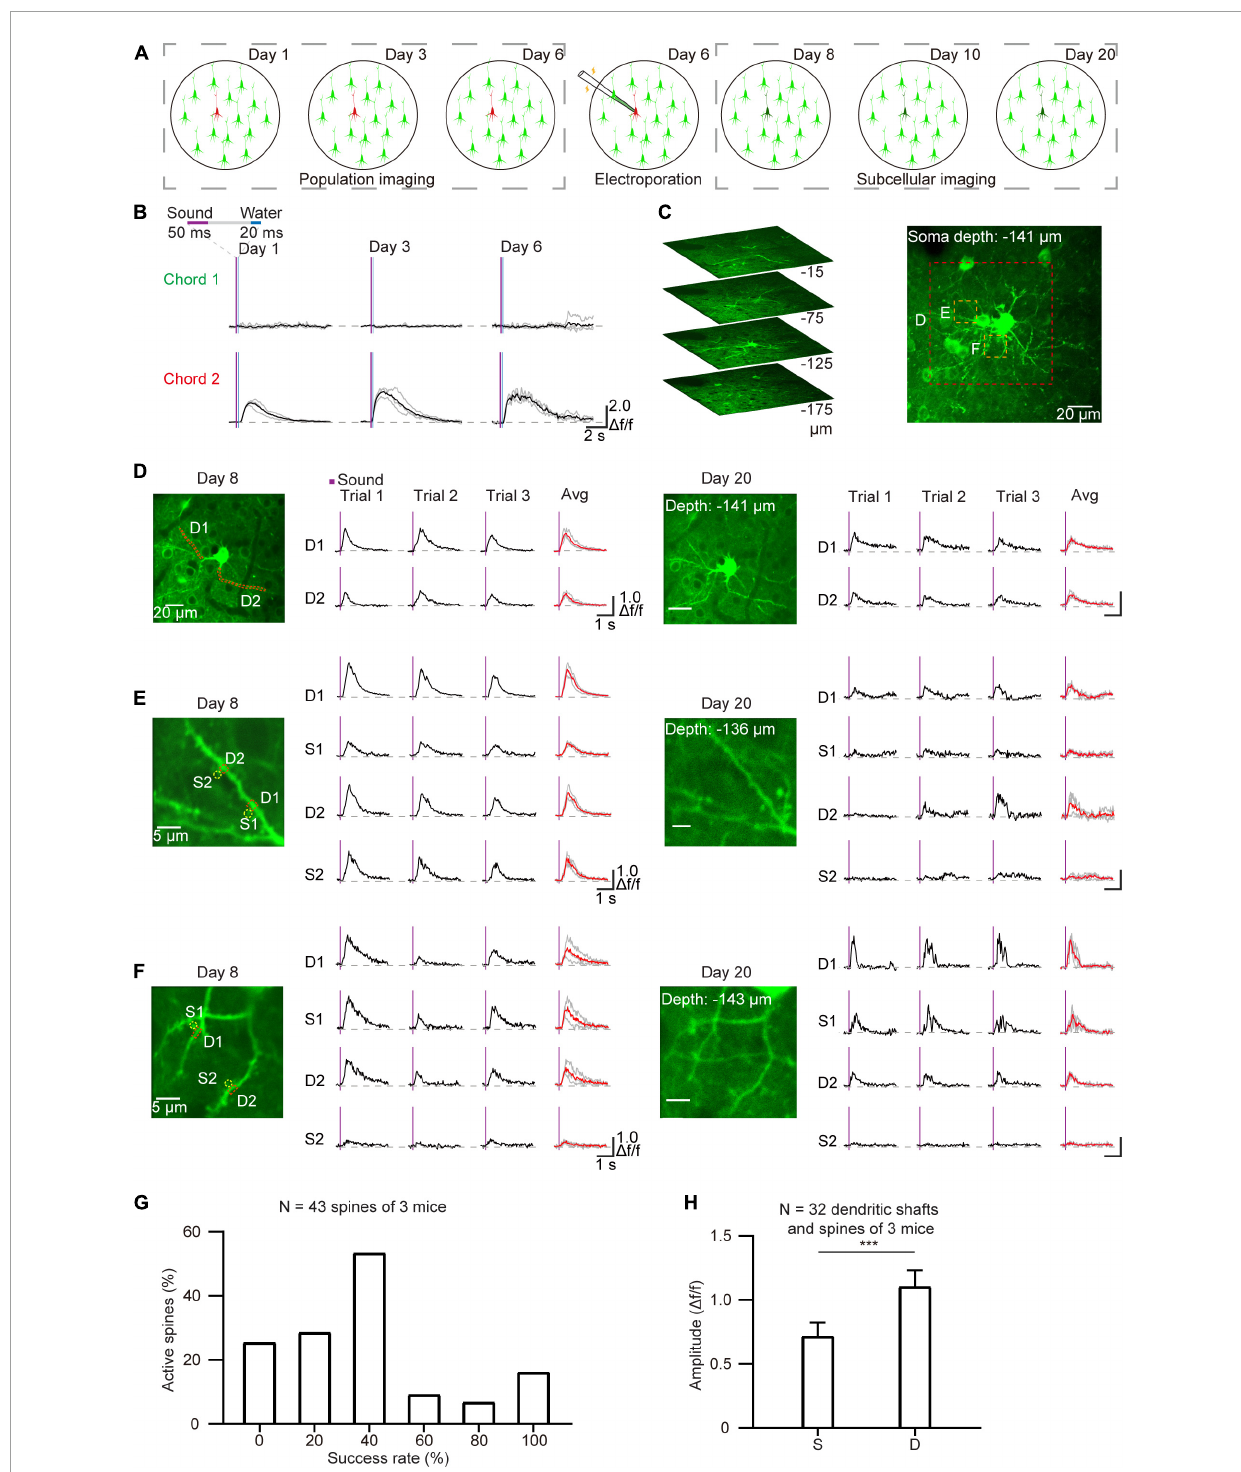
FIGURE5 Chronic subcellular imaging after daily two-photon population imaging. (A) Schematic diagram of chronic subcellular imaging after daily two-photon somatic imaging on the AuC. Day 1–6: daily two-photon population imaging; Day 6: targeted electroporation after chronic imaging; Day 8–20: chronic subcellular imaging of the targeted neuron. (B) Ca 2 + signals of the targeted neuron respond to two chords during chronic two-photon imaging. (C) Reconstruction of the targeted cell after electroporation. (D) Chronic subcellular two-photon imaging of the same dendrite segments after electroporation (red dashed region outlined of panel (C) , Day 8–20). (E,F) A similar arrangement as panel (D) showing Ca 2 + signals of the dendrites and spines (yellow dashed region outlined of panel C ). The red lines represent averaged signals from three consecutive trials, and the green lines represent independent signals. (G) Reliability of sound-evoked Ca 2 + signals in active dendritic spines ( n = 43 spines, 3 neurons, calculated from 6 consecutive trials). (H) Amplitude histogram of sound-evoked Ca 2 + signal in active spines (S) and active dendritic shafts (D) ( n = 32 dendritic shafts, 3 neurons), *** P = 0.0006, two-tailed t